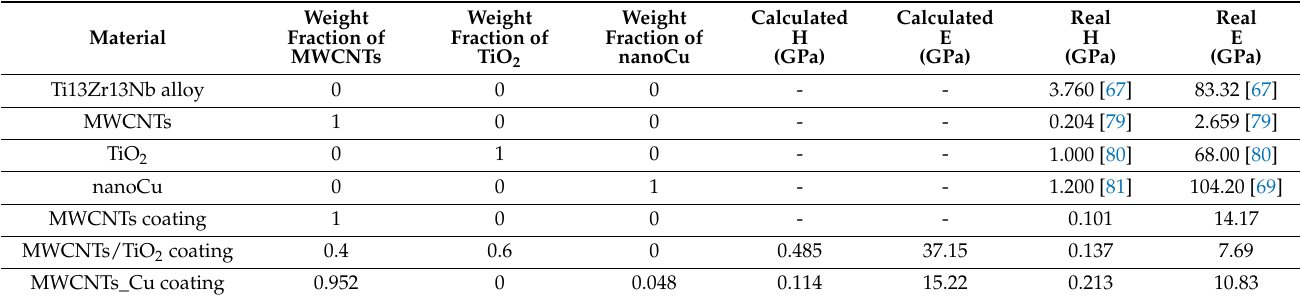
Table 4. A statement of weight fraction, real H, and real E parameters for pure components and MWCNTs composite coatings, compared with H and E parameters calculated based on H-P model for MWCNTs composite